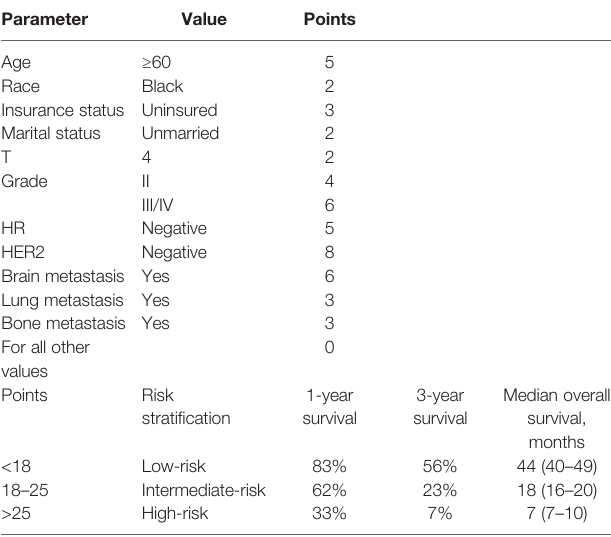
TABLE 3 | Calculation of the score and cut-off points of the risk strati fi cation.